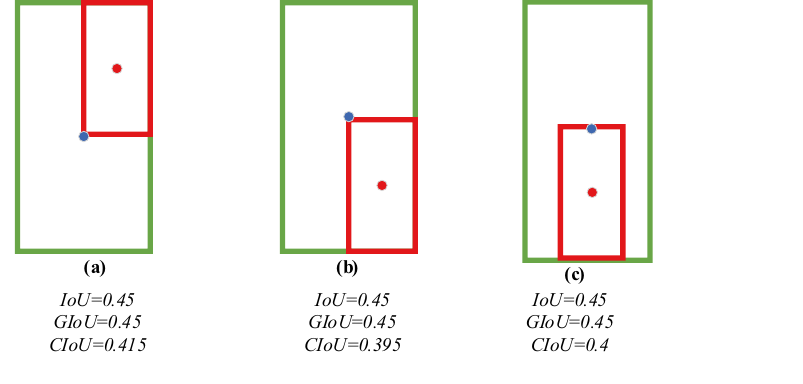
Figure 8. Comparsion of loss